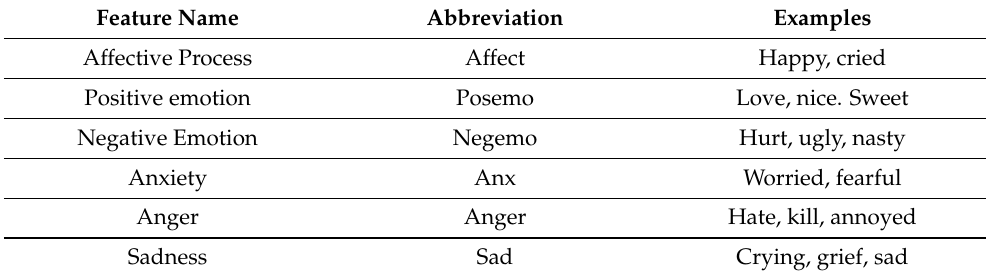
Figure 7. Snapshot of Annotated Data. Table 5. Emotion-related Feature